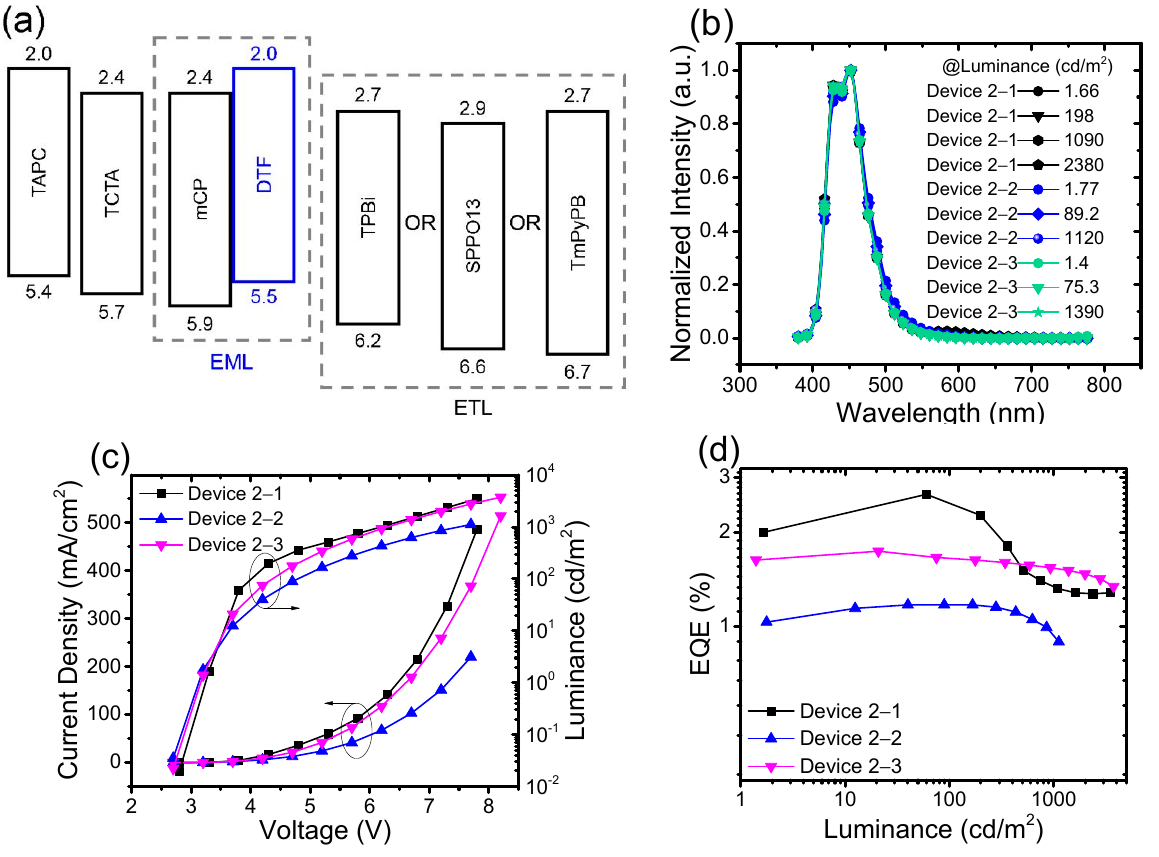
Figure 5. Devices 2-1, 2-2 and 2-3: ( a ) structure and HOMO, LUMO energy levels (in eV); ( b ) EL spectra at different luminance; ( c ) J-V-L plots; and ( d ) EQE curves.